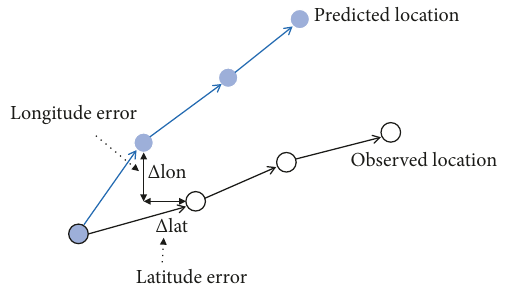
Figure 4: Longitude error and latitude error of predicted location.